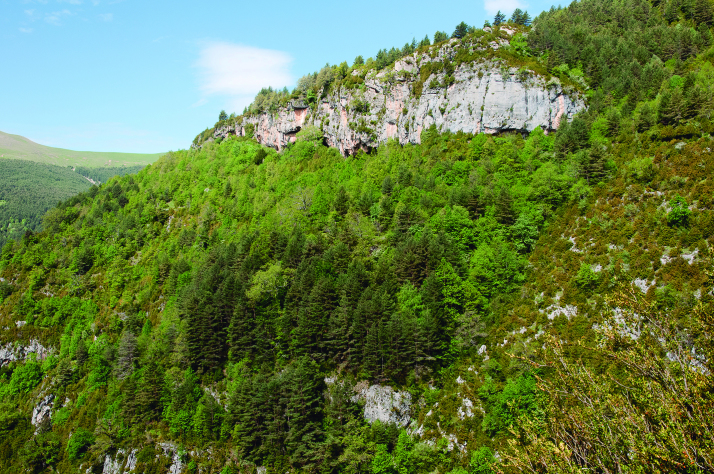
O1 plot O Furno, Q.
subpyrenaica forest